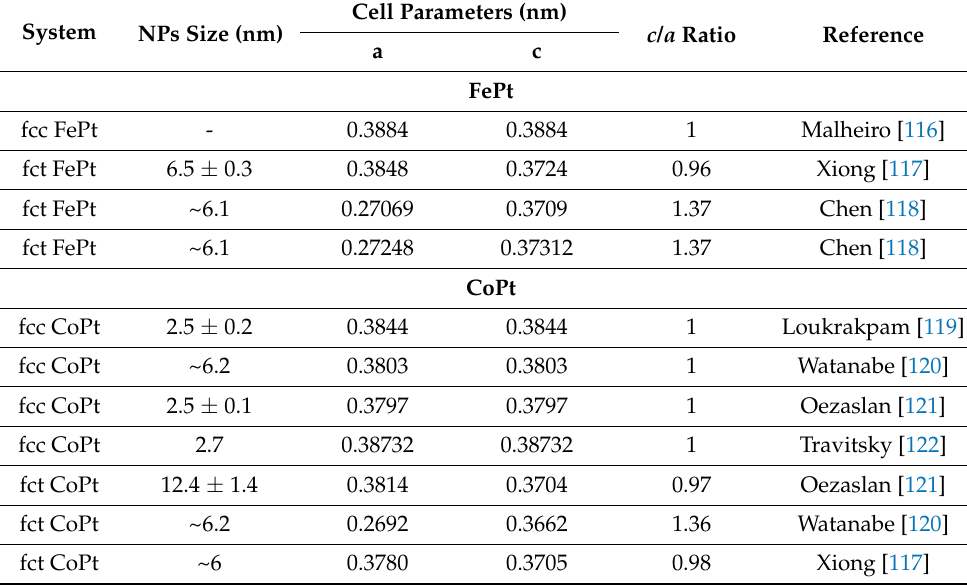
Table 1. Experimental NP size (nm), cell parameters (nm) and c / a ratio for intermetallic MPt (M = Fe, Co and Ni)